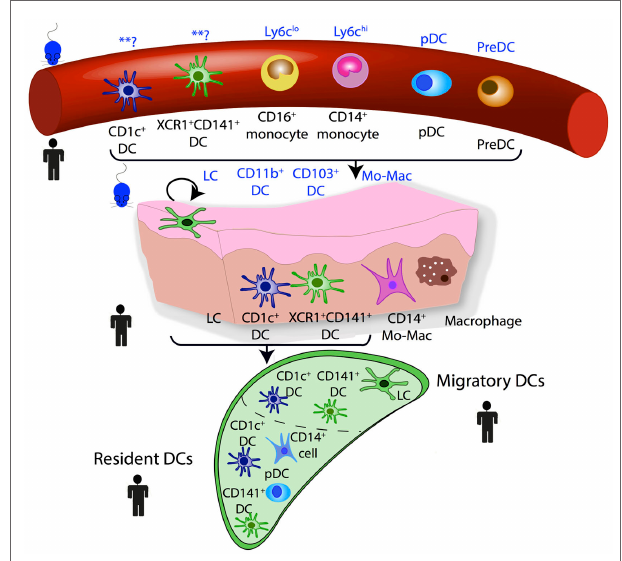
FiGURe 3 | Human and mouse mononuclear phagocyte networks . **? denotes uncertain murine